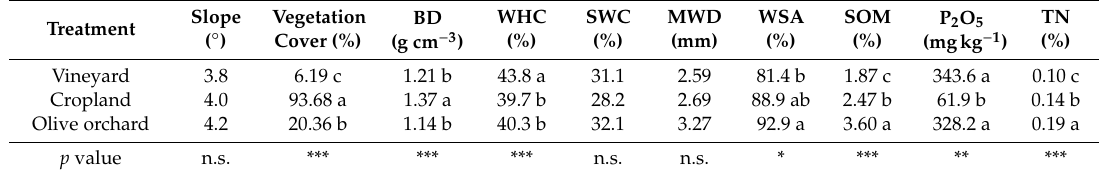
Table 1. Average values of BD, bulk density; WHC, water holding capacity; SWC, soil water content; MWD, mean weight diameter; WSA, water stable aggregates; SOM, soil organic matter; P 2 O 5 , available phosphorous and TN, total nitrogen and one-way and Kruskal–Wallis ANOVA analysis. The e ff ects of soil management on soil properties. Small letters in the column represent the di ff erence in treatment e ff ects at p < 0.05. ns, not significant at p <